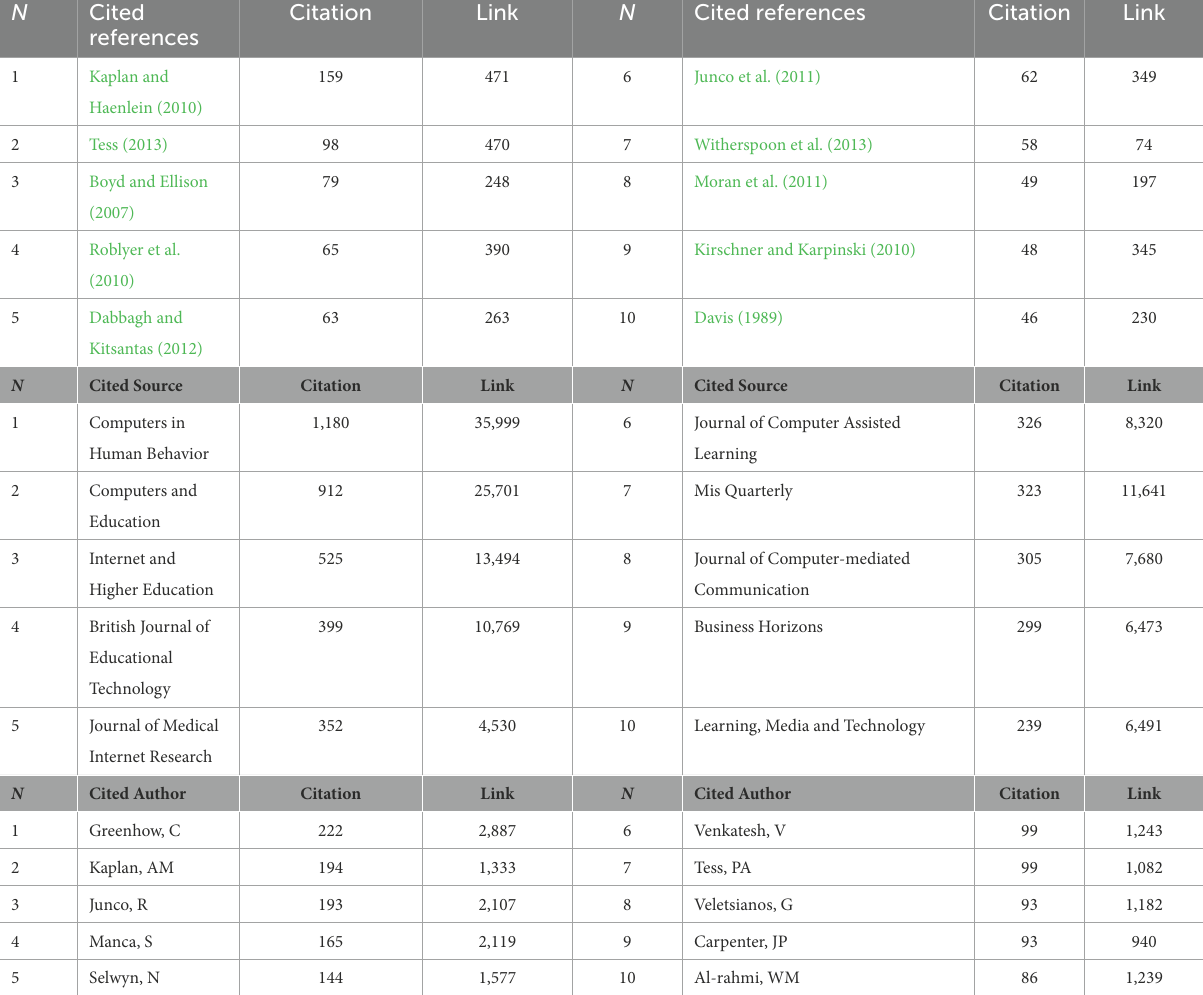
TABLE 7 Top 10 cited references, cited sources, and cited authors based on